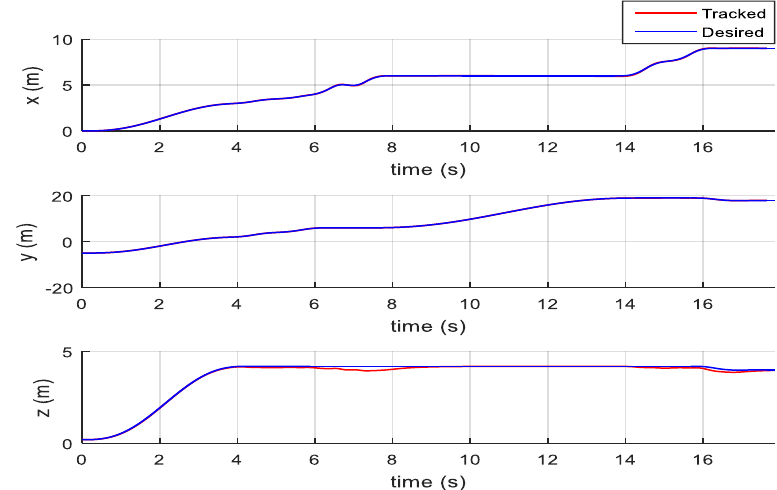
Figure 11. Desired and tracked trajectories (Cartesian states).